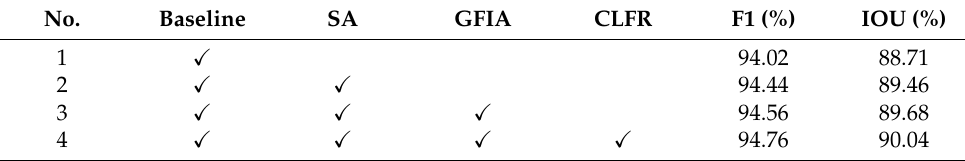
Table 7. Ablation study with different component combinations on the WHU Building Dataset.